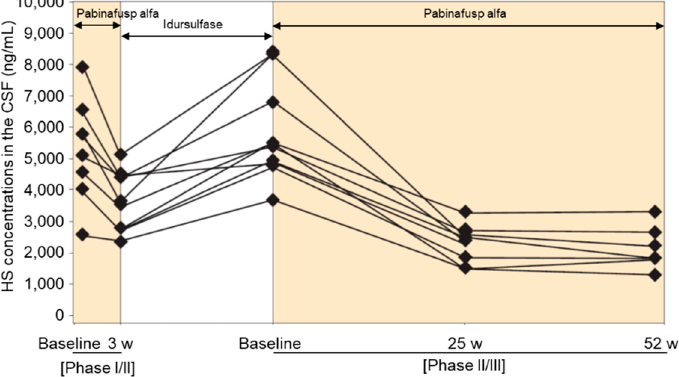
Figure 6. Time course of heparan sulfate (HS) concentrations in the cerebrospinal fluid (CSF) of participants in both phase I/II and phase II/III clinical trials of pabinafusp alfa. Reproduced from the article by Yamamoto and Kawashima [145] with modifications. Copyright© 2022 licensed under Creative Commons Attribution License (CC BY).